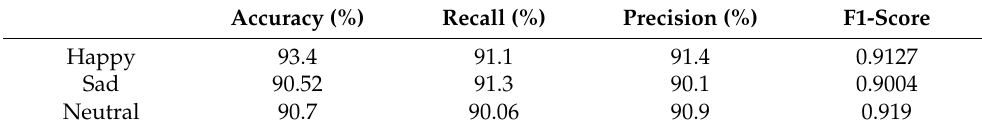
Table 7. Class-wise performance of the DCCA-based fusion method on DEAP dataset.